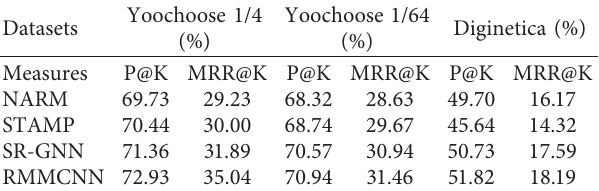
Figure 3: MRR@20 of different models. Table 3: The performance of different datasets ( K � 20).